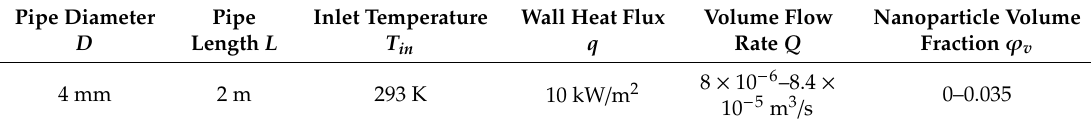
Table 2. Parameters used for the simulation scenarios for ethylene glycol-based silicon nitride (EG-Si 3 N 4 ) nanofluid.